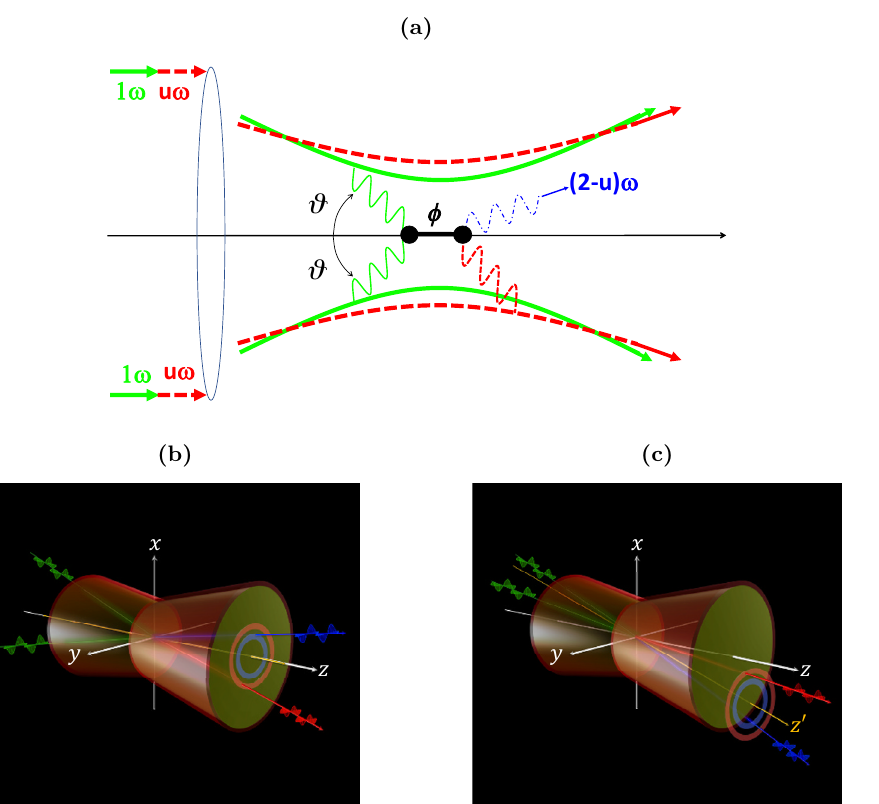
Figure 1 . Stimulated resonant scattering in a quasi-parallel collision system (QPS) and the clas- si(cid:12)cation of collision geometries. (a) Conceptual drawing of stimulated resonant photon-photon scattering in QPS, realizable when a coherent (cid:12)eld with energy ! (solid green line) is combined with another coherent (cid:12)eld with energy u! (0 < u < 1) (dashed red line) and both (cid:12)elds are focused by a lens element in vacuum. The emission of signal photons with energy (2 (cid:0) u ) ! (dash-dotted blue line) is stimulated as a result of energy-momentum conservation in the scattering process ! + ! ! (cid:30) ! (2 (cid:0) u ) ! + u! via a resonance state (cid:30) . (b) Symmetric-incident and coaxial scattering, where the incident angles of two photon wave vectors and their energies are symmetric, and the transverse momenta of photon pairs, p T , always vanish with respect to the common optical axis z . (c) Asymmetric-incident and non-coaxial scattering, where the incident angles of two photon wave vectors and their energies are asymmetric, resulting in a (cid:12)nite value of p T with respect to the common optical axis z . The zero- p T axis ( z 0 -axis) is always con(cid:12)gurable for arbitrary pairs of two incident wave